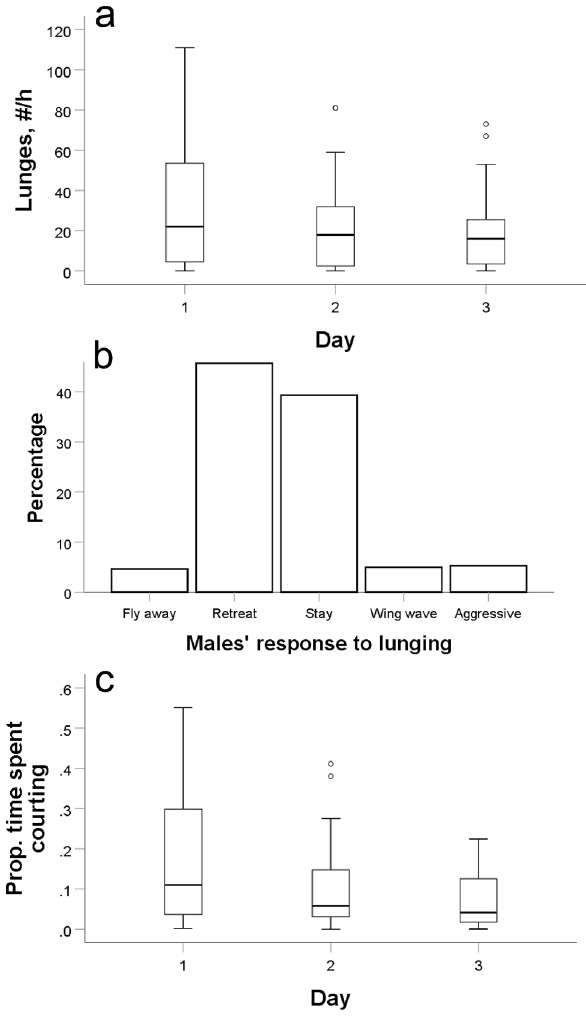
Figure 3. ( a ) Male–male aggression over 3 days depicted as the number of lunges per h at each fruit. The horizontal lines in the boxplots show the medians, the boxes contain the middle 50% of data (interquartile range, IQR), the whiskers above and below each box represent values within ± 1.5 of the IQR, and points depict outliers (n = 59 h of video recordings). ( b ) The types of males’ responses to an attack by another male (n = 905 cases). ( c ) The proportion of time males spent courting females over 3 days (n = 59 h of video